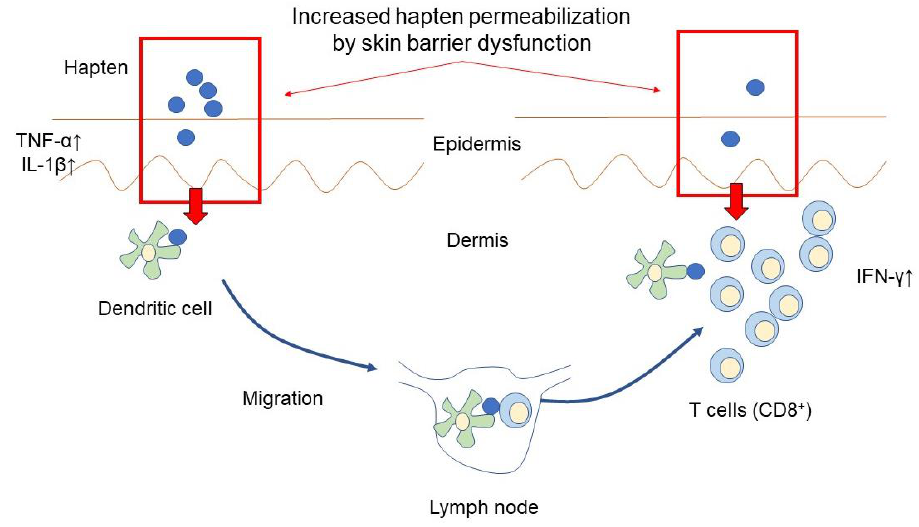
Figure 2. The pathogenesis of allergic contact dermatitis.